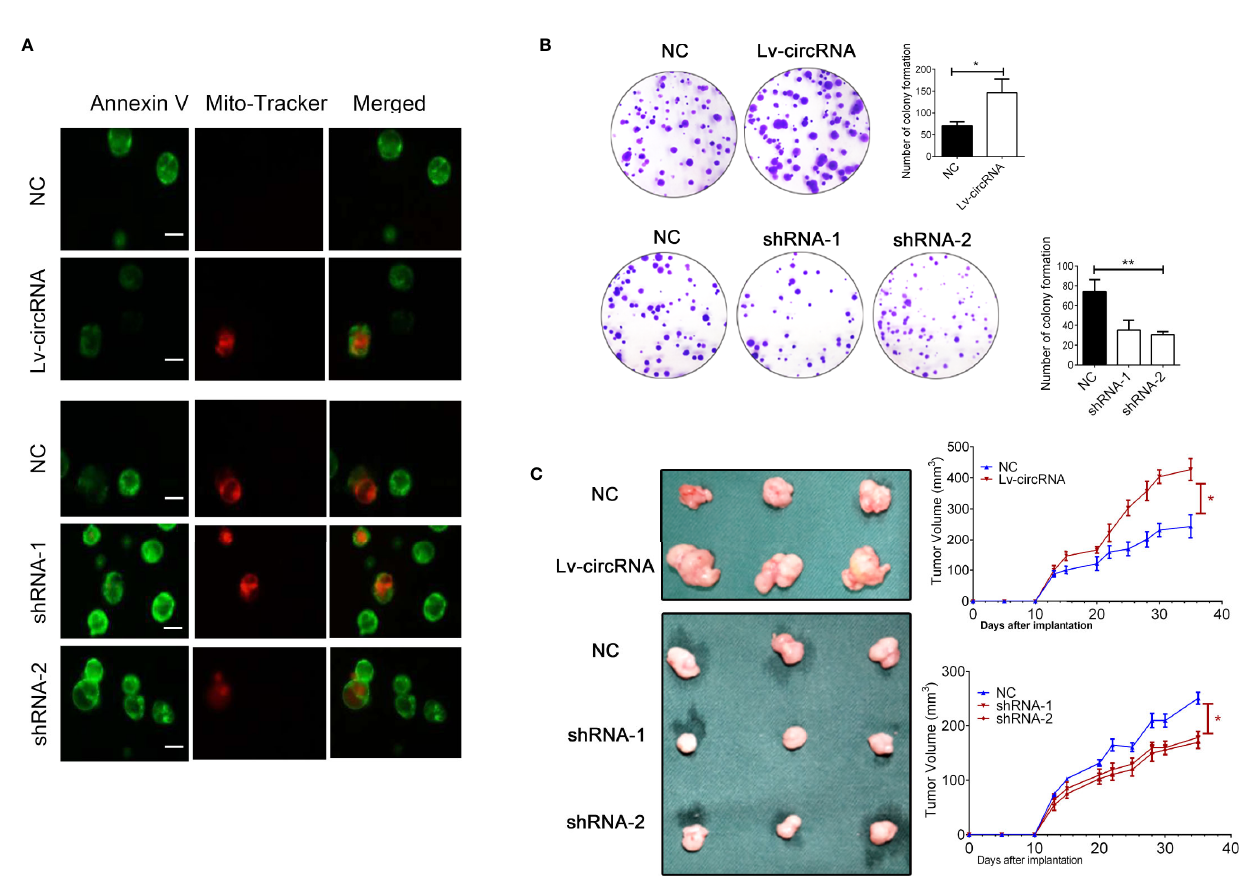
FIGURE 3 | The circ_0032822 promoted cell proliferation while reduced apoptosis of HNSCC. (A) The mitochondrial membrane potential detection through the immuno fl uorescence. Annexin V-FITC (green), Mito-Tracker Red CMXRos (red). (B) Colony formation assay. The F value for the ANOVA analysis between shRNAs and control group was 20.1. (C) Tumor size and growth curve of colorectal cancer cells treated with circ_0032822 overexpression or knocking down lentivirus. *indicated P < 0.05, ** indicated P <